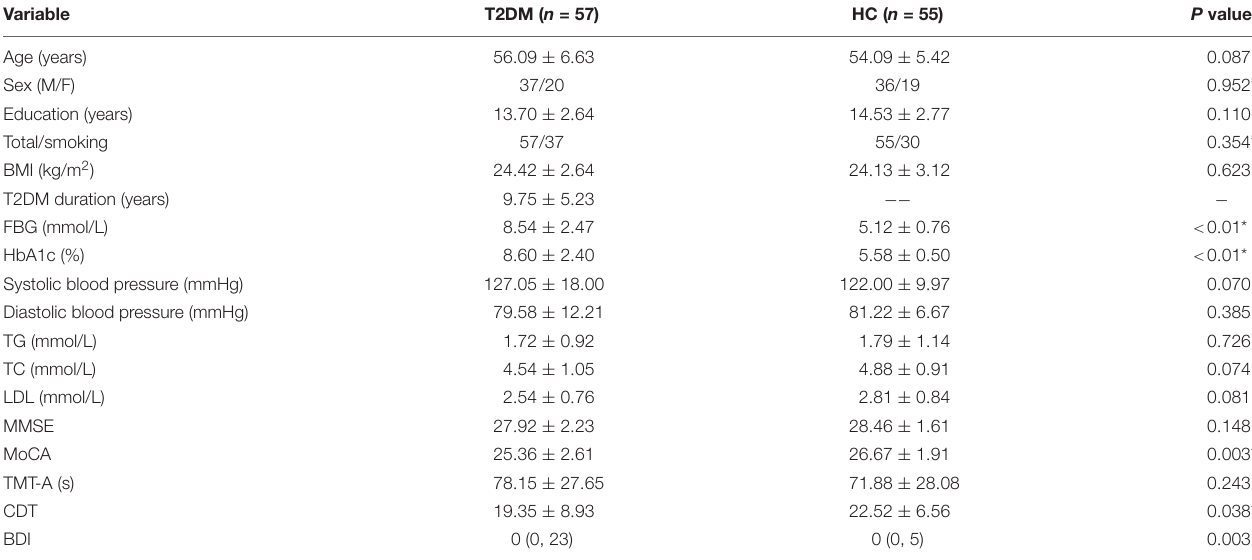
TABLE 1 | Demographic, clinical, and cognitive data of the T2DM and HC groups.